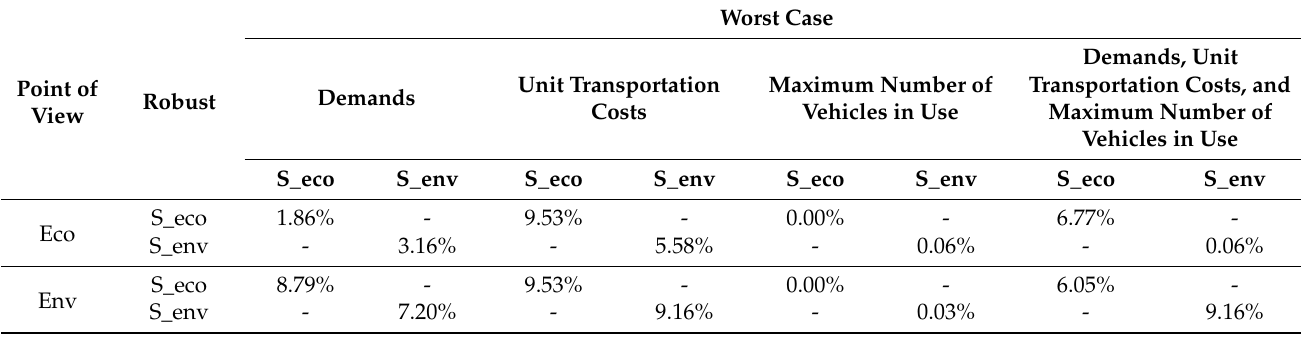
Table 7. Reduction rates for the different studied cases ( %